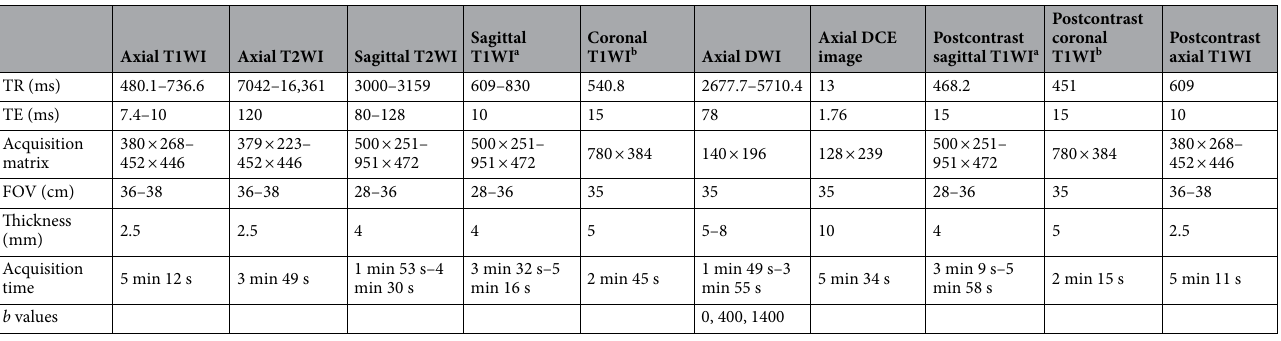
Table 1. Parameters of the magnetic resonance sequences. TR repetition time, TE echo time, FOV field of view, T1WI T1-weighted image, T2WI T2-weighted image, DWI diffusion-weighted image, DCE dynamic contrast-enhanced. a Thoracic or lumbosacral spine. b Pelvic